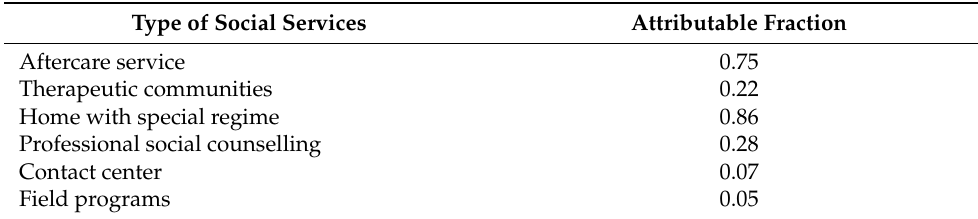
Table 3. Attributable fractions corresponding to different type of social